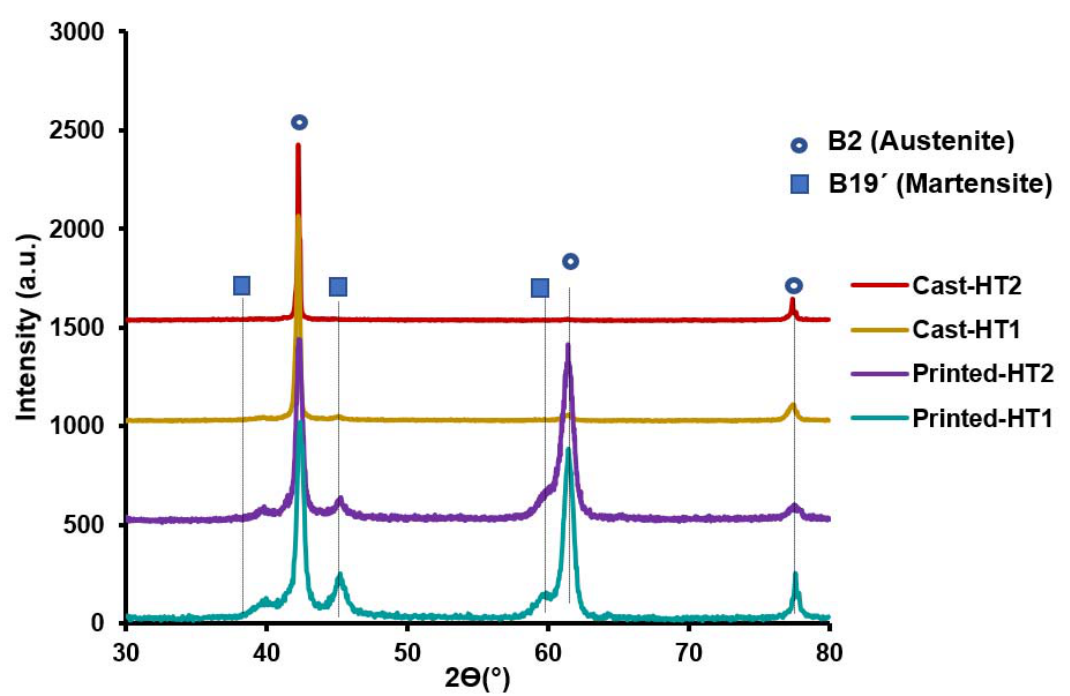
Figure 7. XRD spectra of cast ‐ HT1, cast ‐ HT2, printed ‐ HT1, andprinted ‐ HT2 NiTi samples.